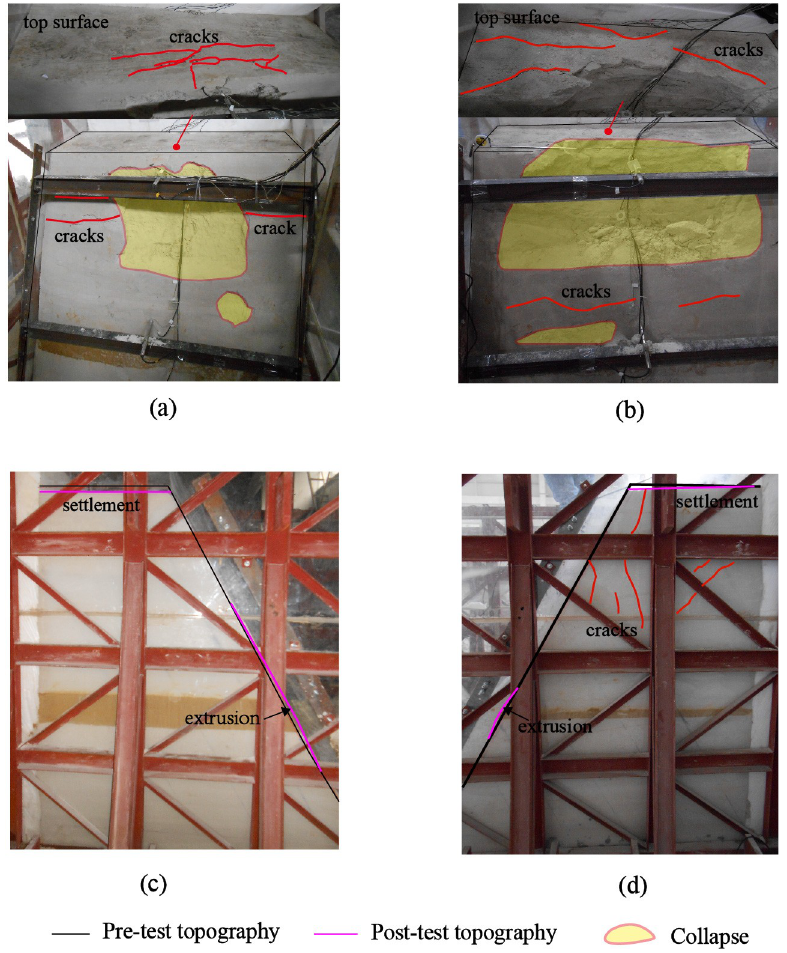
Fig 15. Final deformation and failure (Phase Ⅳ ;) of two model slopes: (a) surface of Slope A; (b) surface of Slope B; (c) side view of Slope A; (d) side view of Slope B.